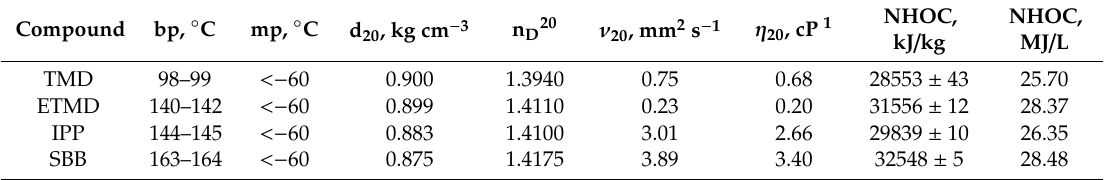
Table 7. The main physicochemical properties of the ketals and the corresponding ethers.